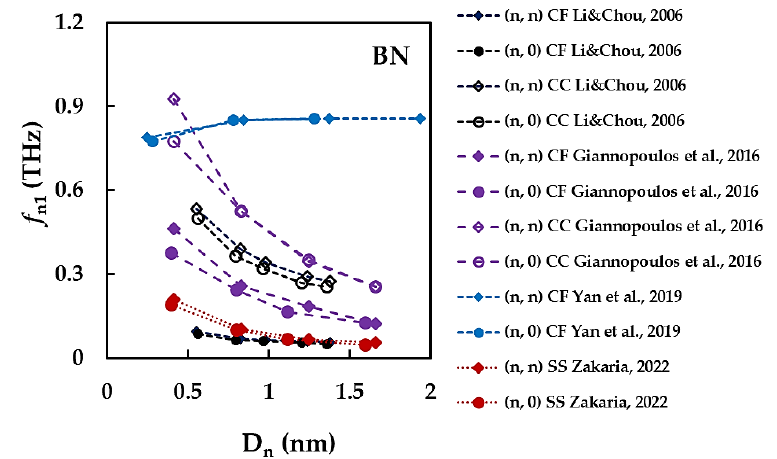
Figure 9. The first fundamental frequency, f n1 , as a function of the nanotube diameter, D n , for BNNTs [34,68,69,71].